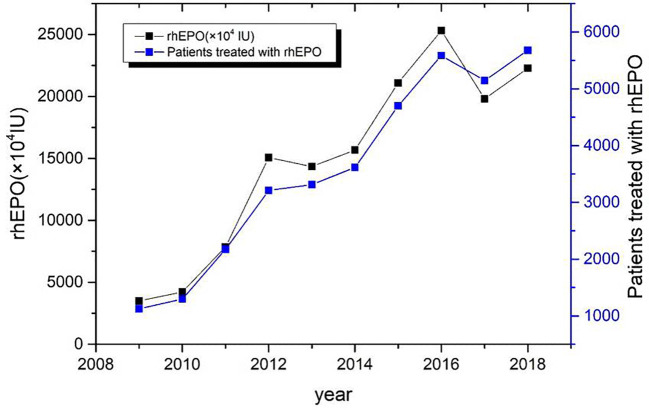
Annual consumption trend chart of rhEPO in a single center from 2009 to 2018.